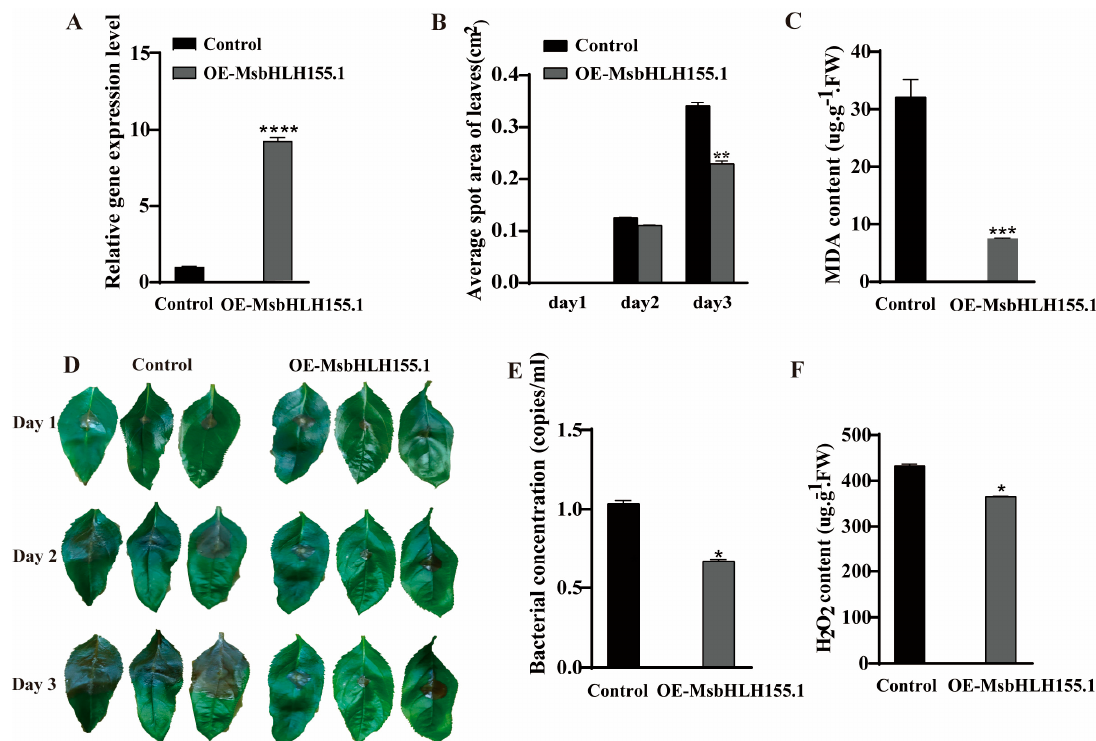
Figure 8. Phenotypic and physiological indexes of overexpression of MsbHLH155.1 ( OE- MsbHLH155.1 ) during canker disease. ( A ) Relative expression of MsbHLH155.1 ; ( B , D ) leaf lesion area after infection; ( C ) MDA content in infected leaves; ( E ) bacterial content in infected leaves; ( F ) H 2 O 2 content in leaves infected by the pathogen. Leaves infected with p1307-flag (empty vector) as controls. (An asterisk indicates a significant difference between treatment and control plants; “*” represents p < 0.05; “**” represents p < 0.01; “***” represents p < 0.001; “****” represents p < 0.0001).